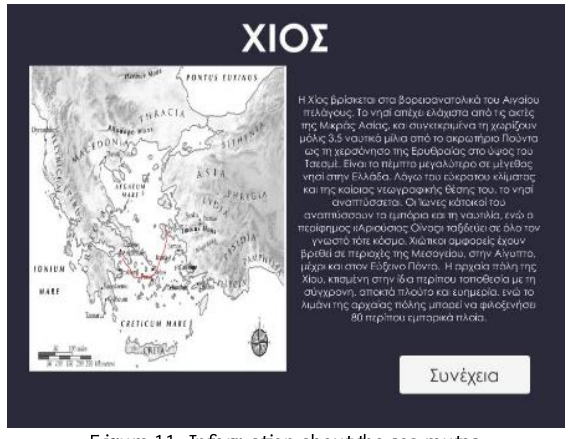
Figure 11. Information about the sea routes